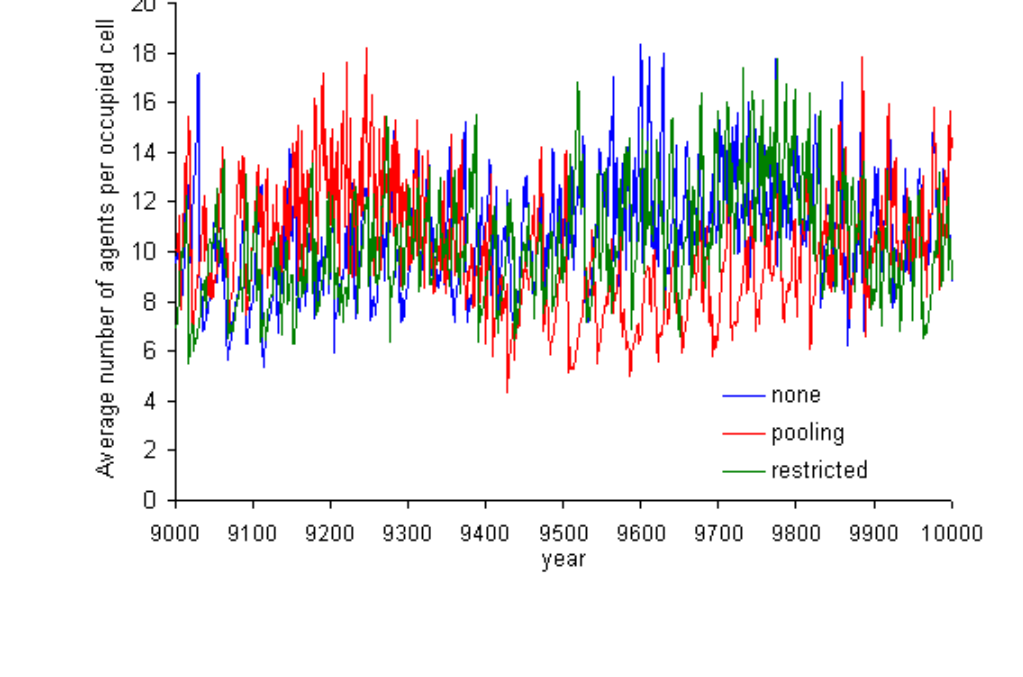
Fig. 6. Population density for typical runs for three types of sharing mechanisms within the